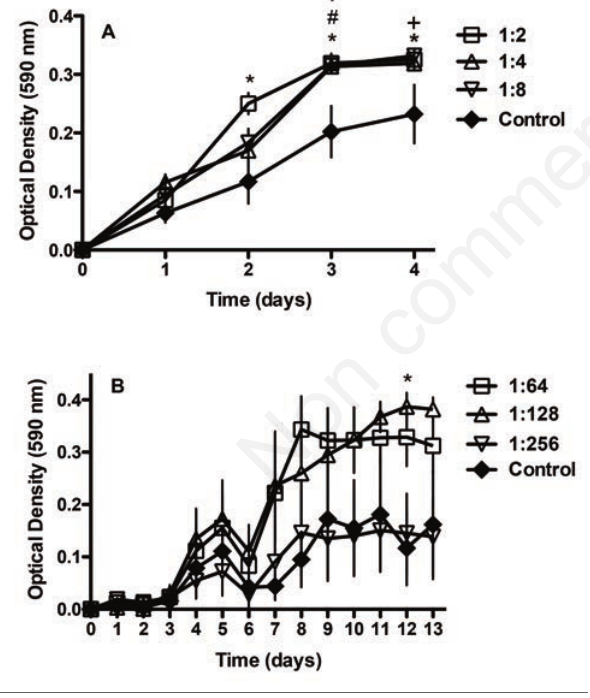
Figure 1. Inclusion of Oxyrase® for Broth (OB) in culture medi- um enhances the rate of recovery of Mycobacterium smegmatis (MS). The optical density (590 nm) of MS grown in LB broth containing serial dilutions of OB was measured until growth ceased or contamination was observed. The average optical den- sity all inoculated wells on day 0 was subtracted from that of each at all subsequent time points. Only the dilutions of OB that affected MS growth are shown. A) Experiment 1. Asterisks, pound signs, and pluses indicate significant differences between controls and 1:2, 1:4, and 1:8 OB-treated cultures, respectively (P<0.05). B) Experiment 2. Asterisks indicate significant differ- ences between controls and 1:128 OB-treated cultures (P<0.05).